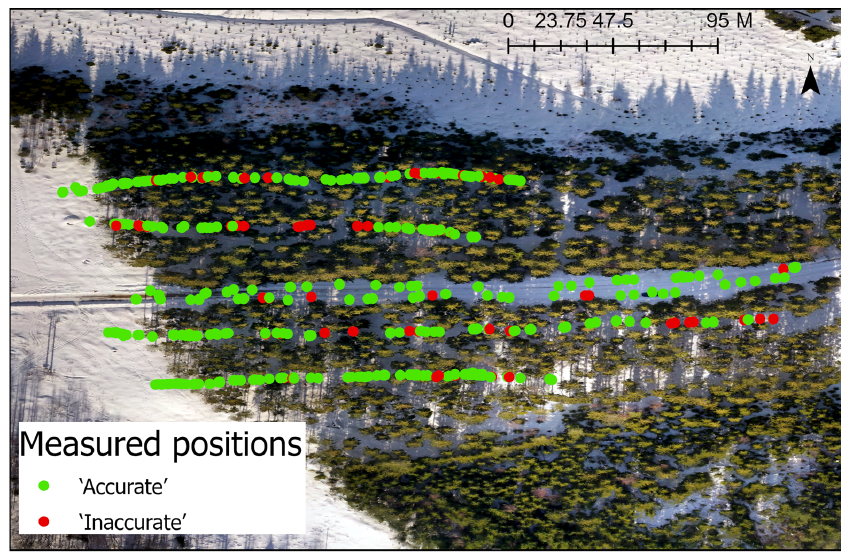
Figure 4. Spatial distribution of the classified measured positions using the Trimble R12 GNSS receiver mounted on a harvester.